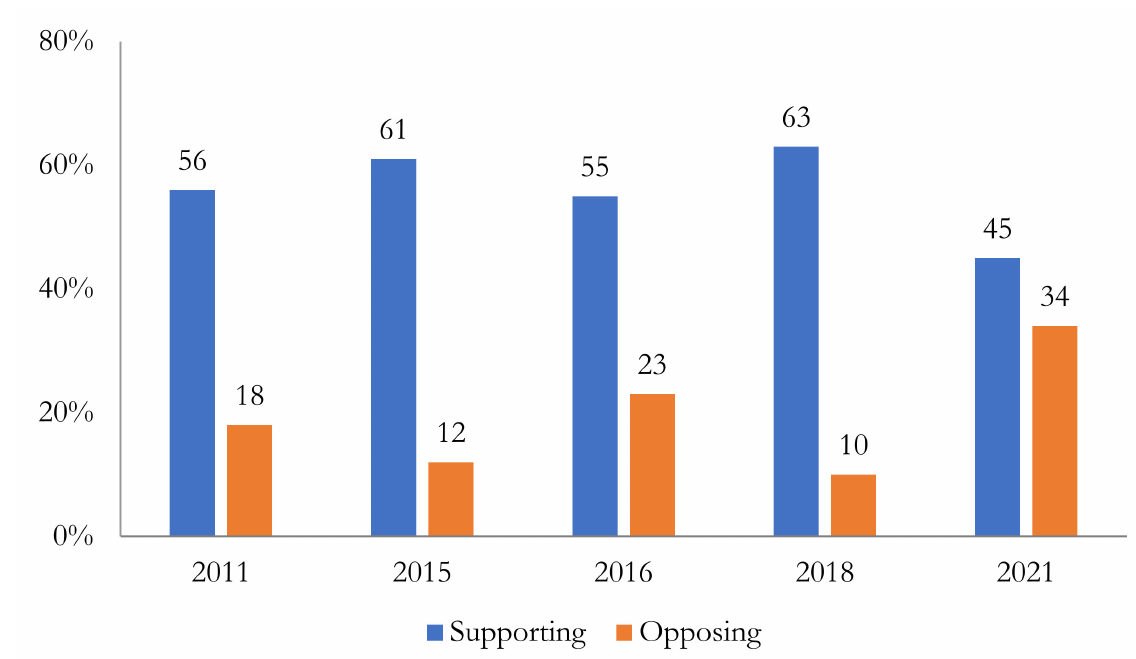
Figure 2. Attitudes of Icelanders towards the establishment of a Central Highlands National Park. Summary of surveys 2011–2021